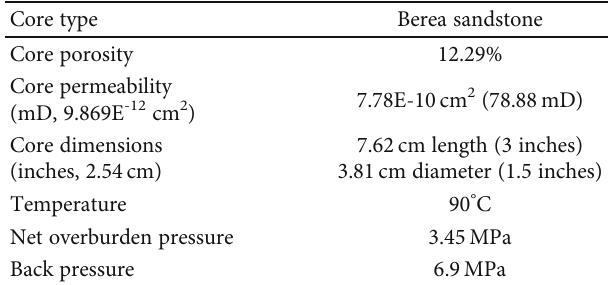
Figure 3: Flooding apparatus schematic. Table 8: Core fl ooding experiment